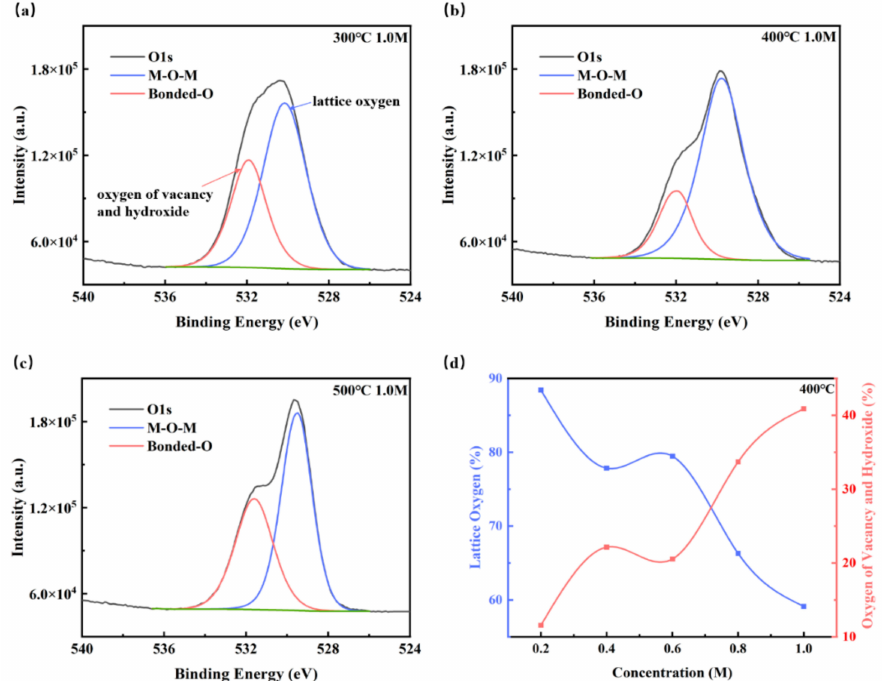
Figure 10. XPS spectra of oxygen 1 s for the ZYAMO thin films at: ( a ) 300 ◦ C, 1.0 M, ( b ) 400 ◦ C, 1.0 M, and ( c ) 500 ◦ C, 1.0 M. ( d ) The tendency of oxygen content with concentration changes under 400 ◦